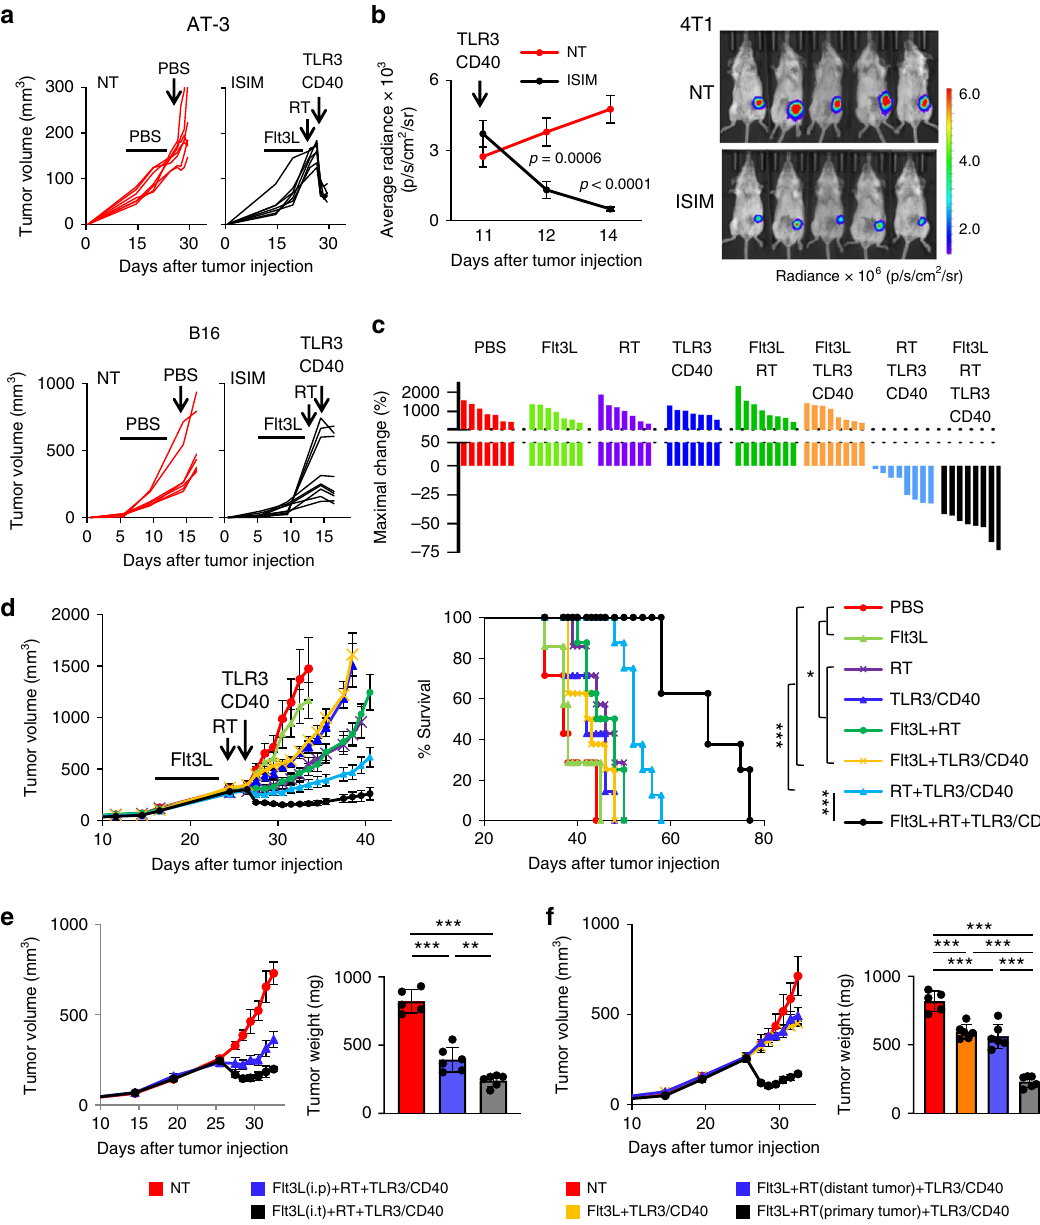
Fig. 2 In situ immunomodulation (ISIM) triggers rapid regression of established poorly T cell-in fi ltrated tumors and improves survival. a Individual tumor volume curves of AT-3 (upper) and B16 (lower) tumor-bearing mice treated with PBS (NT) or ISIM. n = 7 mice per group (AT-3) and 9 mice per group (B16). b Bioluminescence imaging of 4T1-luc tumor-bearing mice treated with PBS (NT) or ISIM ( n = 5 mice per group) on day 14. The data panel shows mean radiance at each time point as indicated. Statistical signi fi cance was determined by a two-tailed t -test. c , d Waterfall plots ( c ), tumor volume curves (mean), and survival curves ( d ) in AT-3 tumor-bearing mice in different treatment as indicated. Waterfall plots show maximal change of tumor volume at the day when TLR3/CD40 agonists were administered. n = 7 mice (PBS, Flt3L, RT, TLR3/CD40) and 8 mice (any other groups). * p < 0.05, *** p < 0.001 by a log-rank test. e Tumor volume curves (mean) and tumor weight (mg) in AT-3 tumor-bearing mice. Flt3L was administrated intraperitonially (i.p.) or intratumorally (i.t.) followed by RT and TLR3/CD40 agonists. n = 5 mice (NT) and 6 mice (any other groups). f Primary tumor volume curves (mean) and tumor weight (mg) in mice bearing bilateral AT-3 tumors. To establish distant tumors, AT-3 cells were implanted on the left side 2 days after injection to right mammary fat pad (day 0). n = 5 mice (NT) and 6 mice (any other groups). Primary tumors were harvested 7 days after TLR3/ CD40 stimulation ( e , f ). Data shown in a – d are representative of three independent experiments. ** p < 0.01, *** p < 0.001 by one-way ANOVA with Tukey ’ s multiple comparisons ( e , f ). Mean± SEM. Source data are provided as a Source Data fi tumors. We treated AT-3 tumor-bearing mice with agonistic anti- superior tumor control and survival in all three tumor models CD40 Ab, poly(I:C), or their combination following Flt3L (Fig. 4a and Supplementary Fig. 8). Dual TLR3/CD40 stimulation administration and RT. While mice treated with either CD40 or was required to upregulate CD40, CD70, and CD86 on CD103 + DCs in TdLN (Fig. 4b). Phenotypic analysis of circulating T cells TLR3 agonist responded with modest tumor growth delay and indicates that stimulation with TLR3 agonist increased T CM increased survival, combined TLR3/CD40 stimulation resulted in